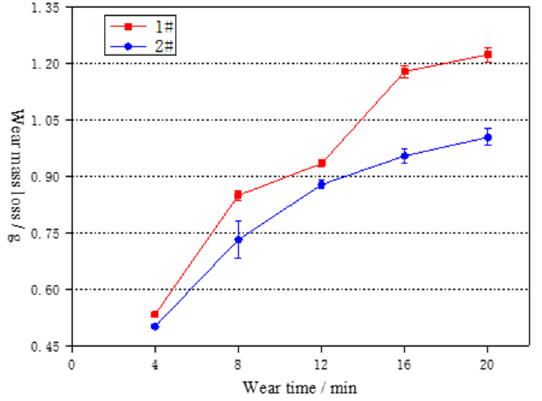
Figure 16. Relationship between wear loss and wear time for the tested steels.